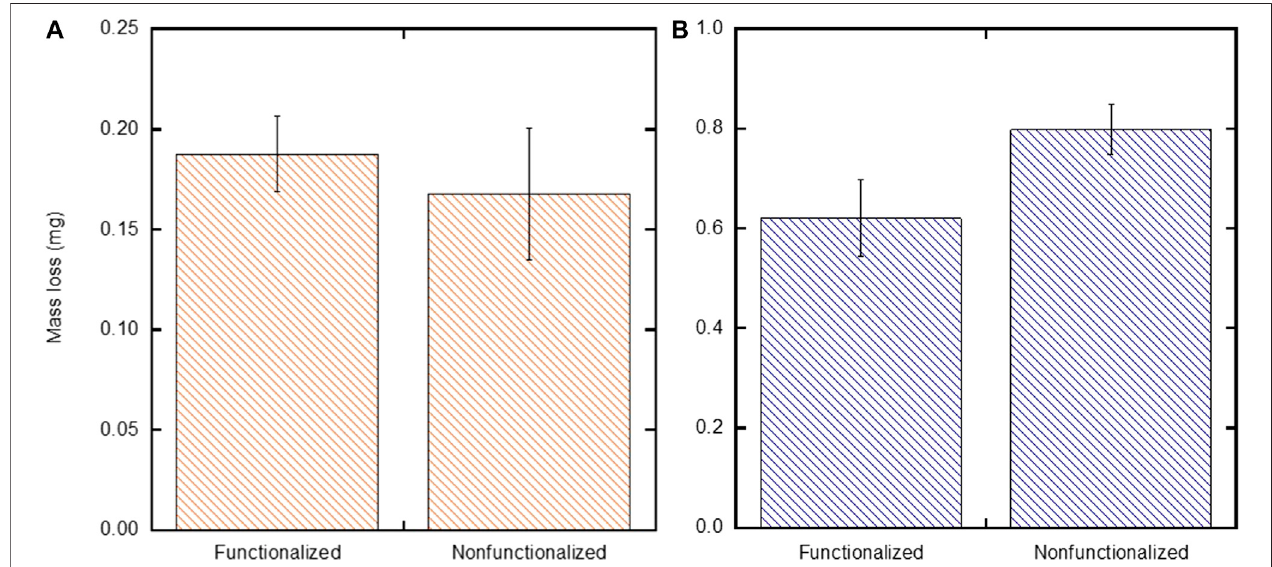
FIGURE8| Comparisonofmasslossbetweennon-functionalizedsubstratesandsubstratesfunctionalizedwithSH-PEG-DPAaftertheTapeTest(ASTM-D3359-17) was performed on fi lms deposited with the (A) low particle concentration and moderate fi eld and b) high particle concentration and high fi eld conditions.